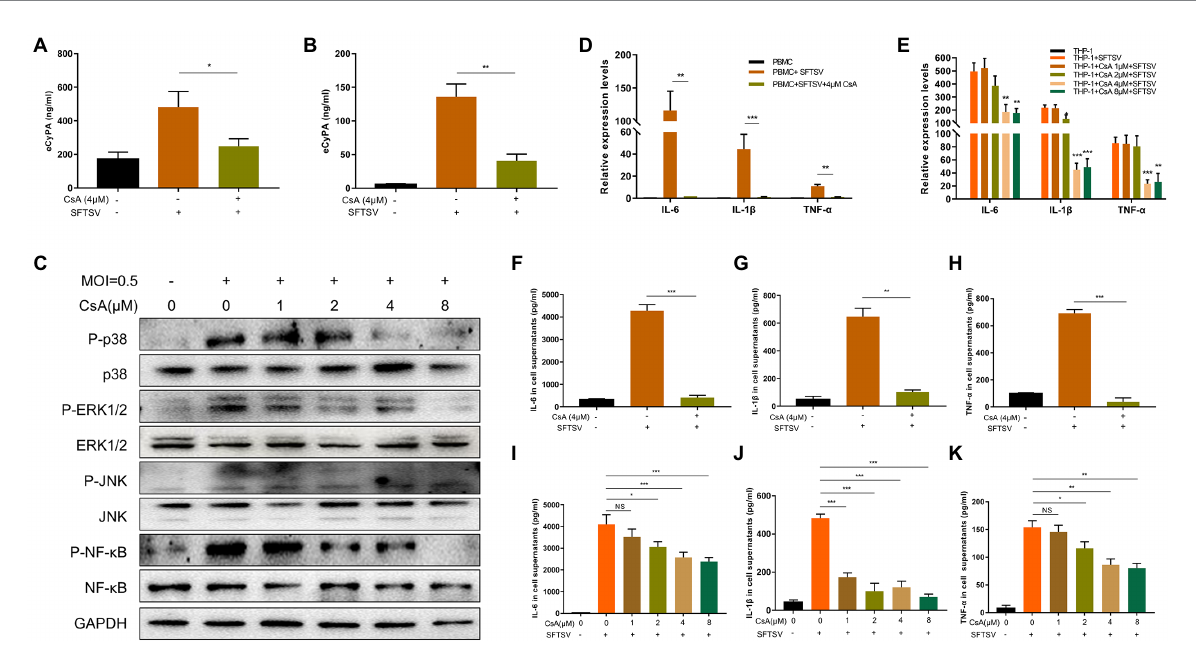
FIGURE 2 CsA inhibits the pro-inflammatory effects of CyPA after severe SFTSV infection. Normal human PBMCs (A) and THP-1 cells (B) were divided into blank group, SFTSV-infected (MOI = 0.5) 12 h group, 4 μ M CsA pretreatment for 12 h, and SFTSV-infected 12 h (MOI = 0.5) group. The expression of CyPA in the supernatant of cells in each group was measured by ELISA. (C) THP-1 cells were divided into blank group, SFTSV-infected (MOI = 0.5) 12 h group, CsA pretreatment at different concentrations for 12 h, and SFTSV-infected 12 h (MOI = 0.5) group. The total protein in each group of cells was extracted to detect MAPK pathway activation by Western blot. The mRNA levels of IL-6, IL-1 β , and TNF- α were measured by qRT-PCR in PBMCs (D) and THP-1 (E) . The protein levels of IL-6, IL-1 β , and TNF- α in the supernatants of PBMCS (F–H) and THP-1 (I–K) were correspondingly collected and measured by ELISA. (A,B,D–K) . The values shown represent the mean ± standard error of three independent experiments. * p < 0.05; ** p < 0.01; *** p < 0.001. (C) One representative experiment is